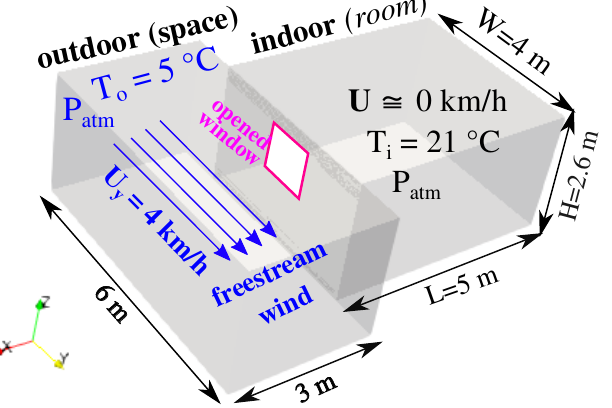
Figure 1. Natural ventilation between an indoor (room) and outdoor space. The boundary and initial conditions show a room of height H = 2.6 m, length L = 5 m and width W = 4 m. Outside the room the freestream velocity (low wind speed U y = 4 km/h) is parallel to the window’s surface 1 × 1 m 2 . The window’s minimum height is placed at a vertical distance of 1.3 m above the ground ( z = 0). The air circulation indoors is assumed to be negligible ( U = 0) initially. At t = 0 the temperature indoors is T i = 21 ◦ C and outdoors is T o = 5 ◦ C. Both the indoor and outdoor spaces are at atmospheric pressure P = P atm